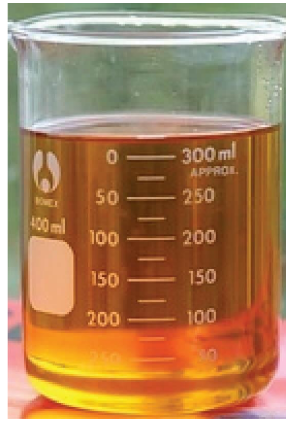
Figure 2: Biodiesel of waste tyre pyrolysis